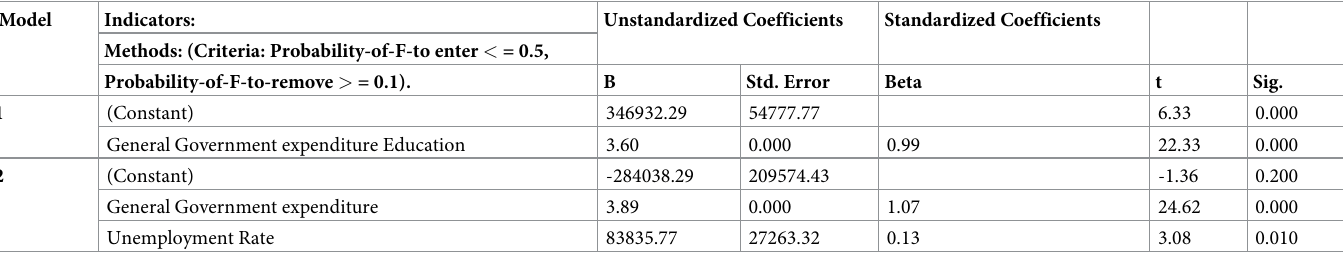
Table 2. Regression coefficients for the relationship between total enrollment, socio-economic factors (general government expenditure, unemployment rate, per capital income, GDP per capita (PPP constant 2011 international $), and GDP at market price) of Pakistan during 2001–02 to 2015–16.